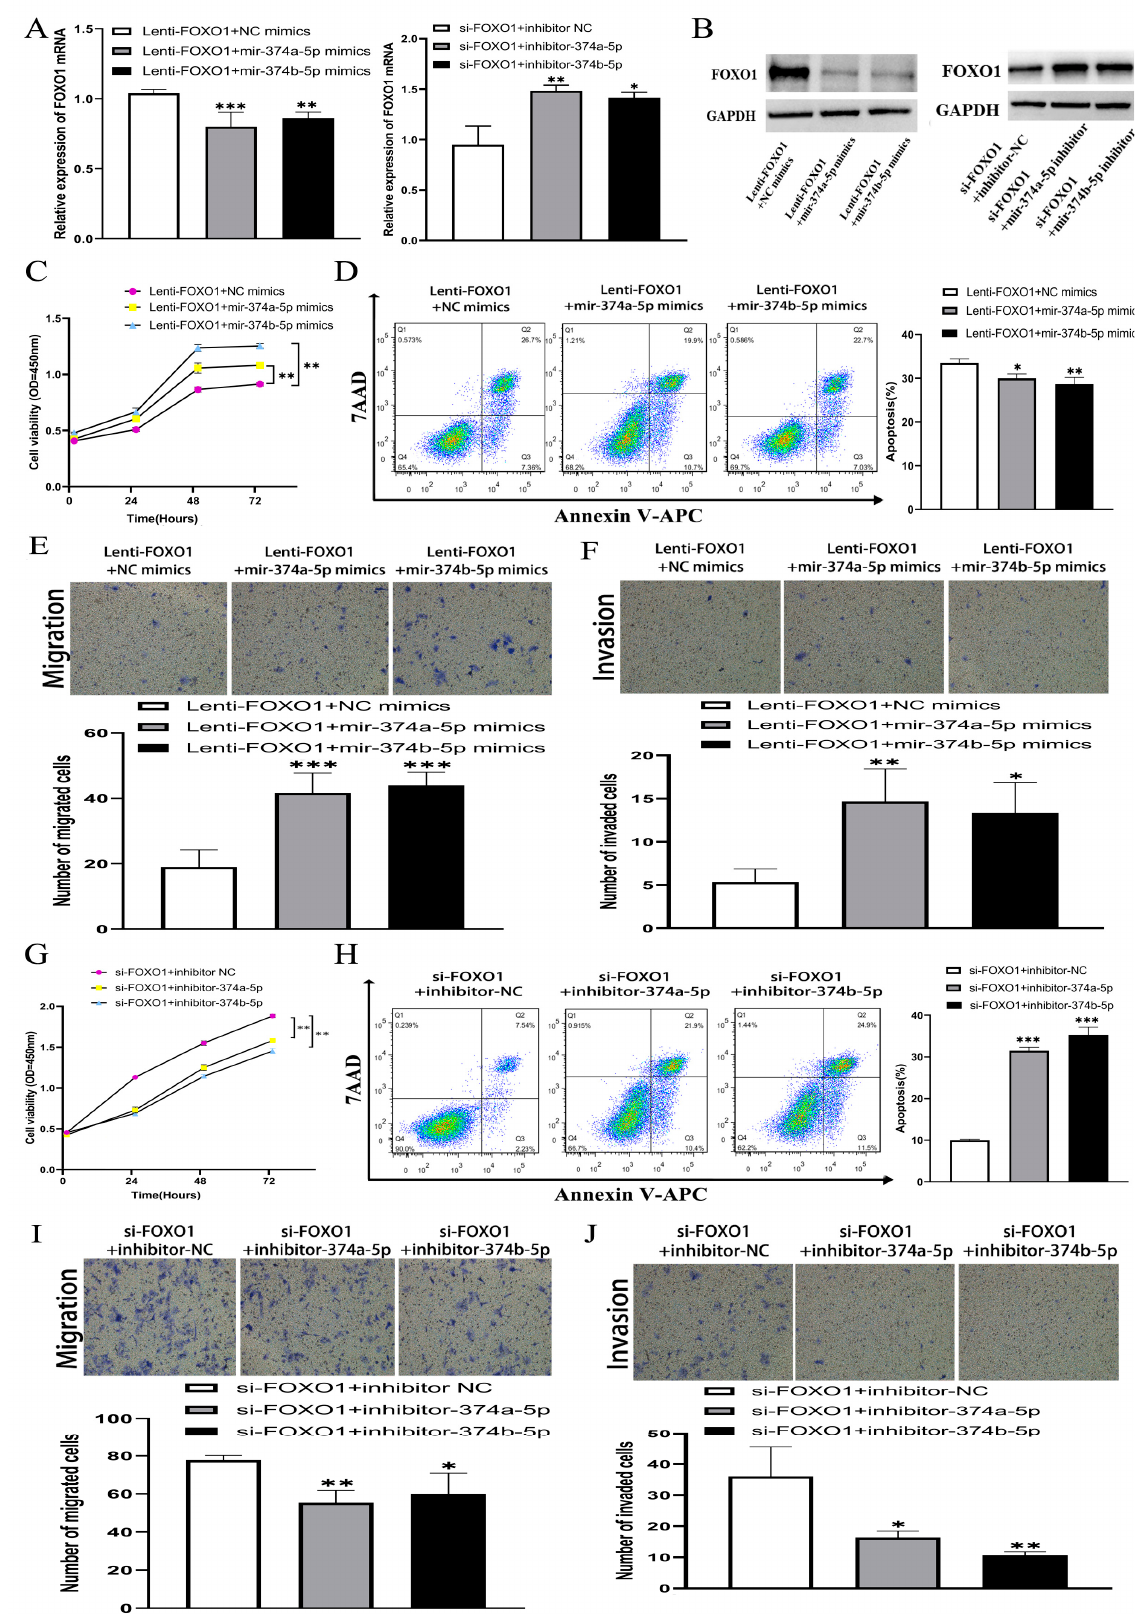
Figure 11. ( A ) the mRNA of FOXO1 overexpression in LM3 cells combined with miR-374a/b-5p mimics significantly reduced FOXO1 expression compared with FOXO1 overexpression with